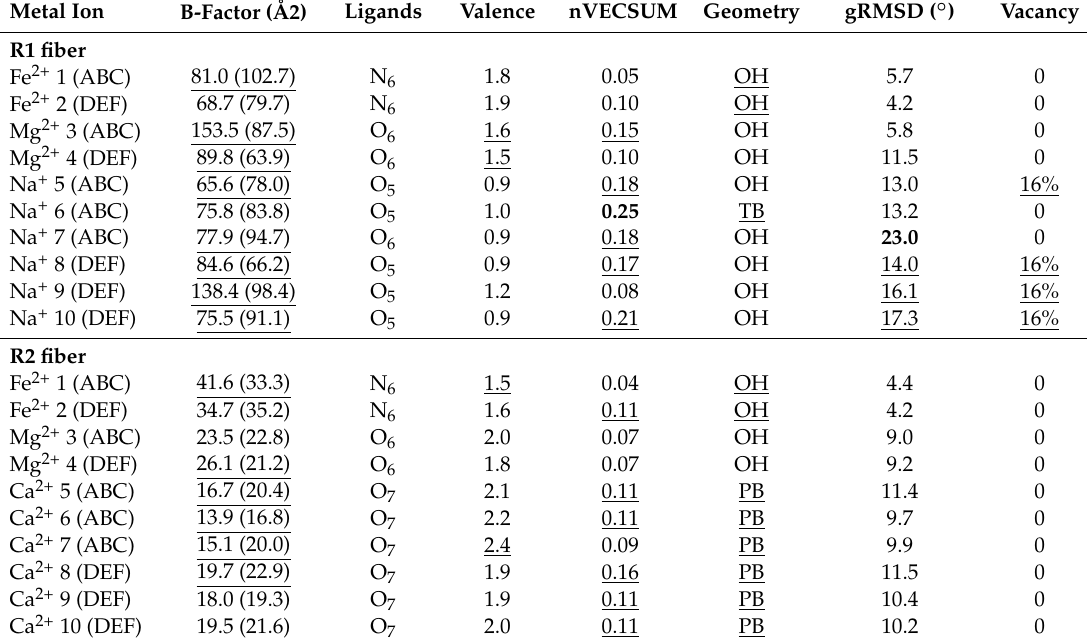
Table 2. Validation and coordination geometry analysis of metal-binding sites in R1 and R2 pyocin fiber structures with the CheckMyMetal web server [59,63]. ABC and DEF indicate the three chains of the two independent trimers comprising the asymmetric unit. The B-factor column gives the isotropic atomic displacement factor for the metal ion and its valence-weighted environmental average in parentheses. Ligands are the elemental composition of the coordination sphere. Valence is the overall bond valence, the average of individual bond valence values for all metal-ligand bonds. For an ideal site, the valence parameter should be the same as the charge of the metal ion. nVECSUM is a summation of the ligand vectors, weighted by bond valence values, and normalized by the overall valence. In a complete coordination sphere, the ligand vectors should sum to zero. The value increases as the coordination sphere becomes less complete. Geometry is a pattern of three-dimensional arrangement of ligands around the metal ion, as defined by the coordination chemistry: OH—Octahedral; TB—Trigonal Bipyramidal; PB—Pentagonal Bipyramidal. gRMSD is the overall root mean square deviation of the geometry angles (L-M-L angles) compared to the ideal geometry, in degrees. Vacancy is the percentage of unoccupied sites in the coordination sphere for a given geometry. The values of parameters